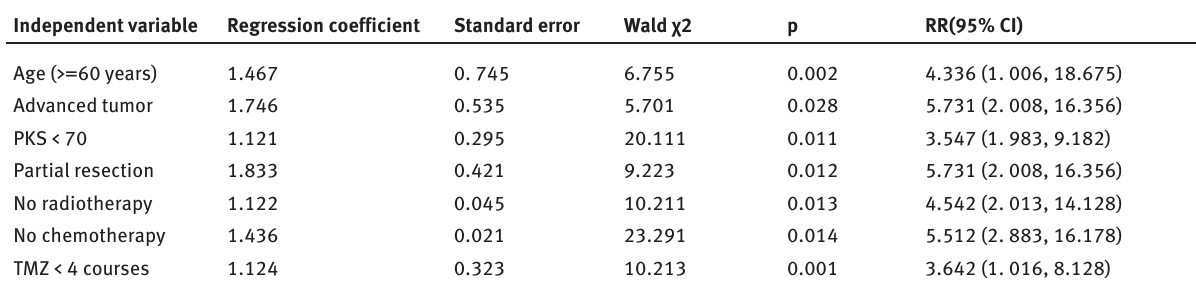
Table 2: Multivariate analysis of prognostic factors in 186 glioma patients